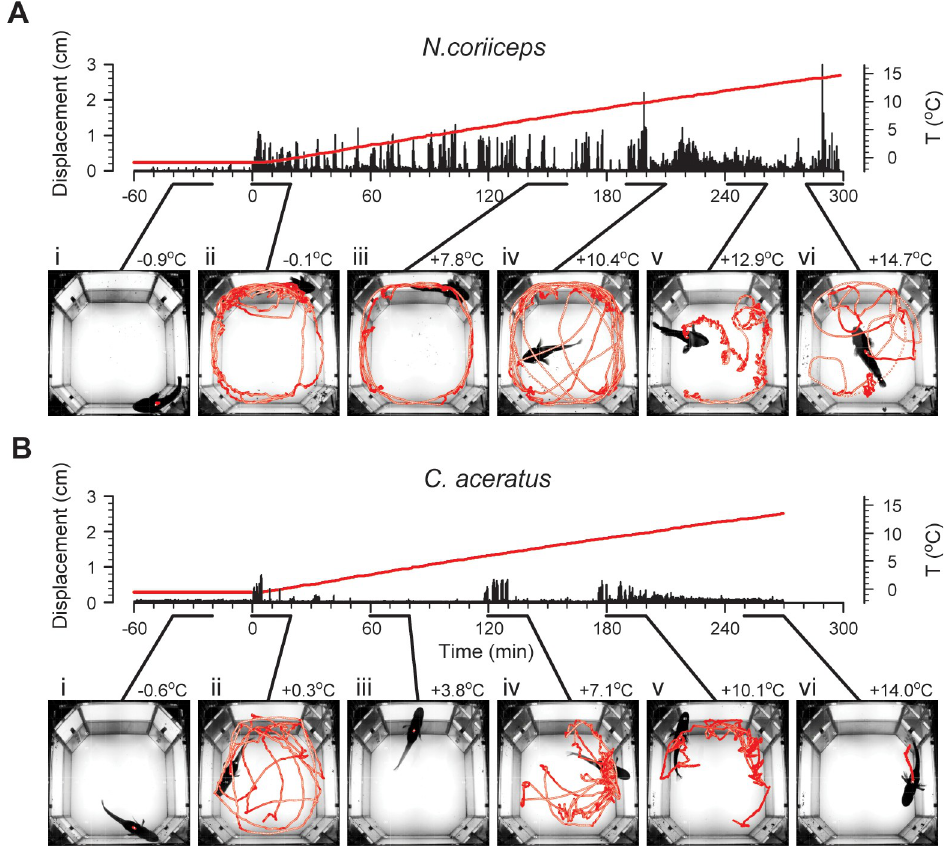
Fig 1. Representative locomotor responses of Hb+ N . coriiceps and Hb- C . aceratus to warming. (A) and (B) represent time plots of absolute instantaneous displacement (left axes) of a single specimen of N . coriiceps and of a single specimen of C . aceratus , respectively. Time “0” corresponds to the beginning of the temperature ramp; negative values correspond to the final sixty minutes of an overnight acclimation in the experimental tank. Red lines represent absolute temperature (right axes) of water, with the maximum corresponding to the LOE. Insets below time plots depict locomotion trajectories for 20 minute time periods at select temperatures (maximal temperatures during these episodes are shown next to the insets). (i) Baseline station-holding. (ii) Early responses to initial rise in temperature. (iii) First period of reduced motility. (iv) Intense locomotion and startle-like behaviors. (v) Second period of reduced motility with multiple startle-like behaviors. (vi) Onset of